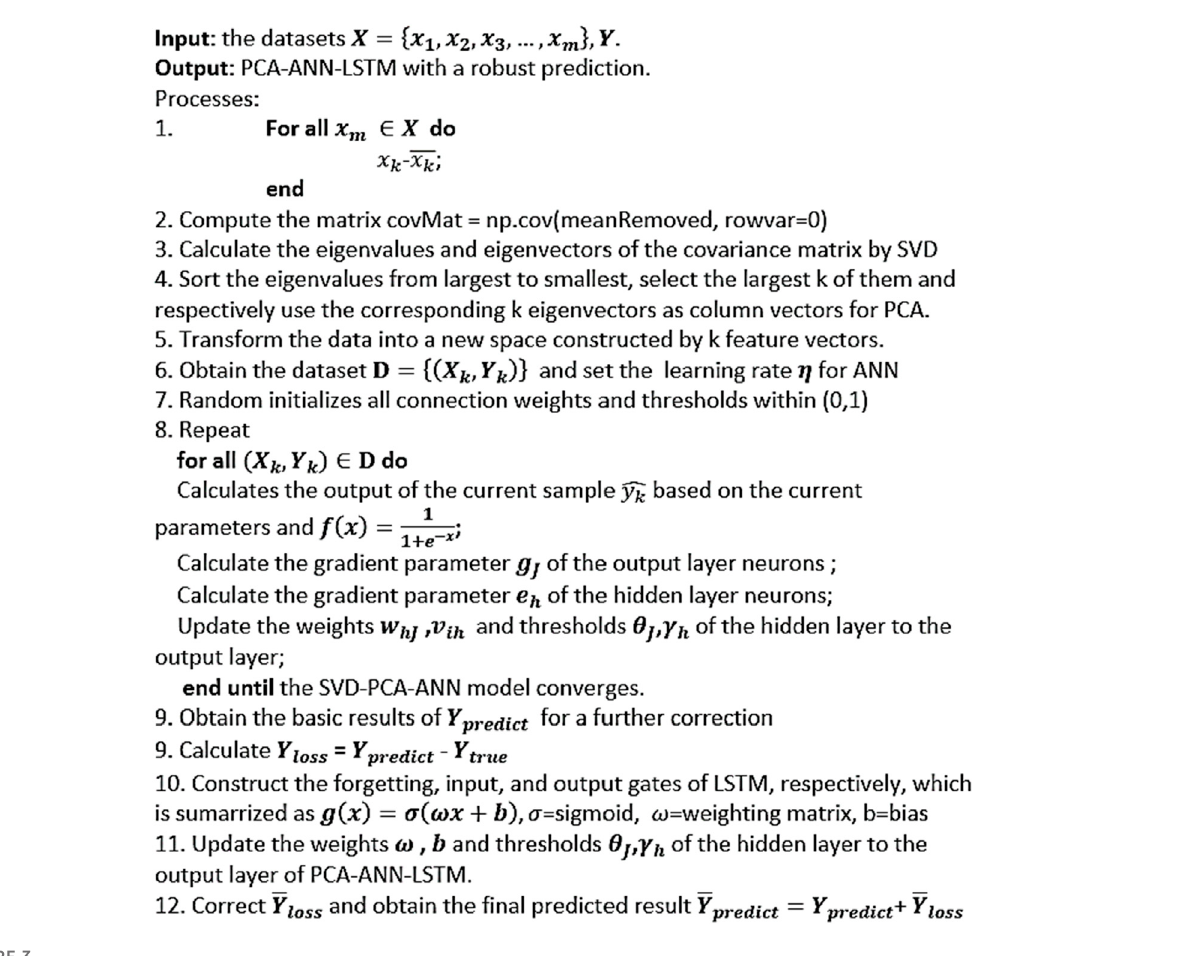
FIGURE 3 Pseudocode of the learning processes based on